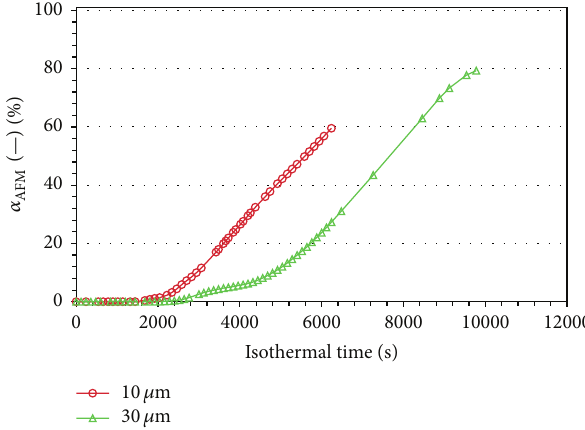
Figure 11: Evolution of averaged amplitude of AFM test on a square area with sides of 10 𝜇 m and 30 𝜇